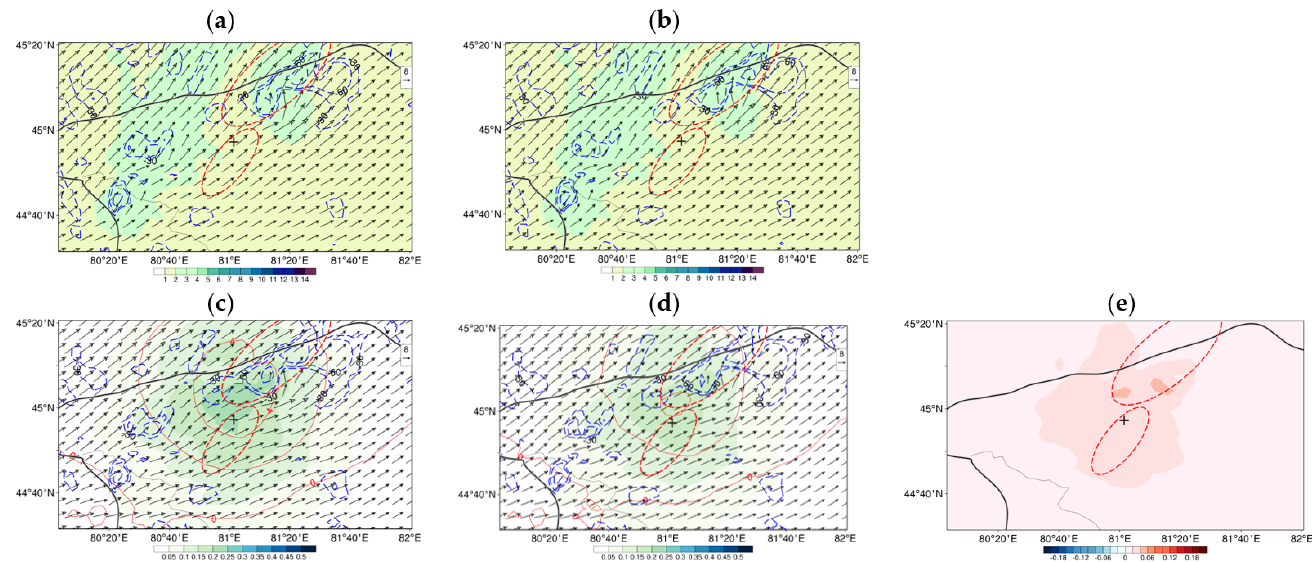
Figure 12. Horizontal cross-section of the analysis and the increment of water vapor (unit g/kg) at 0800 UTC at7000 m. ( a ) The analysis from C2Rad. ( b ) The analysis from C2RadBy. ( c ) The increment from C2Rad. ( d ) The increment from C2RadBy. ( e ) The difference of increment between C2Rad and C2RadBy. The shades in each plot indicate the water vapor mixing ratio (unit g/kg). The solid red lines indicate the increment of temperature (unit 0.001 °C). The dashed blue lines indicate the analysis of negative divergence (unit 1/s).